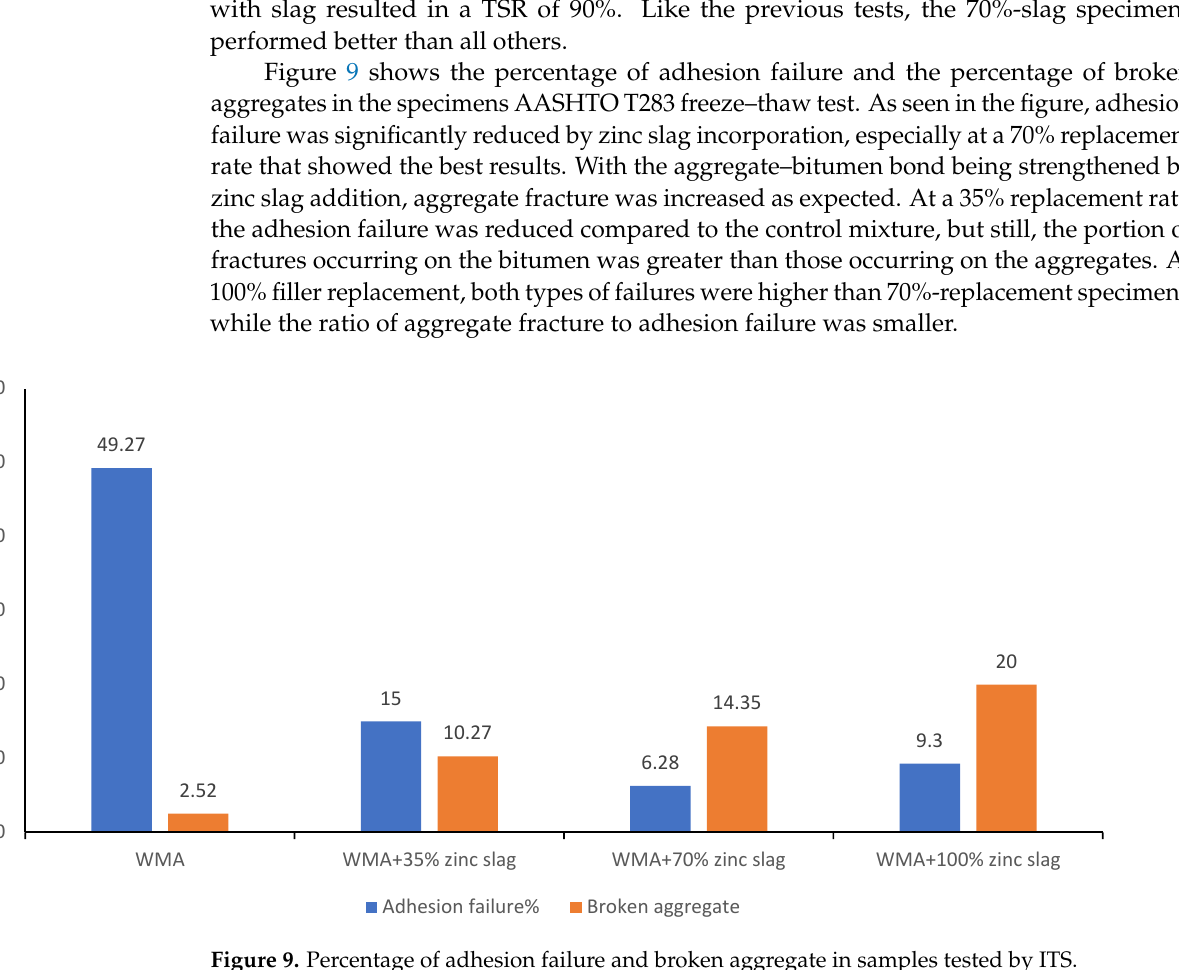
Figure 9. Percentage of adhesion failure and broken aggregate in samples tested by ITS.